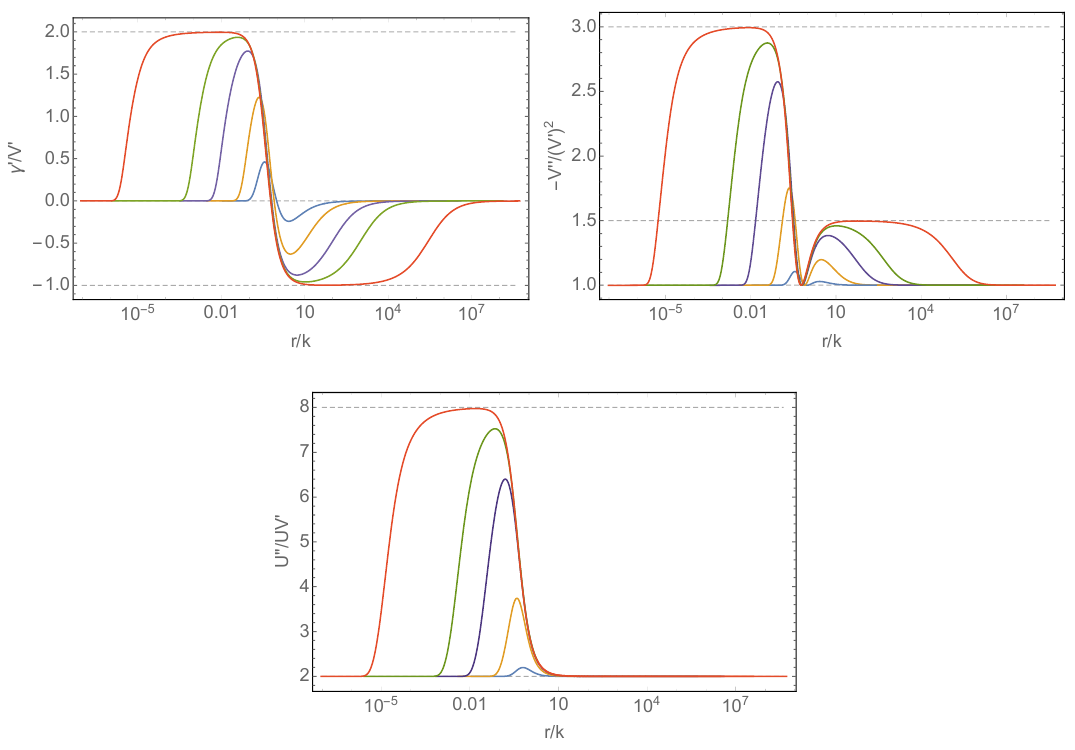
Figure 2 . Plots of various functions associated with the RG (cid:13)ows, as functions of the dimensionless radial coordinate r=k , for various values of the dimensionless deformation parameter (cid:0) =k : blue ((cid:0) =k = 1), orange ((cid:0) =k = 10), purple ((cid:0) =k = 10 2 ), green ((cid:0) =k = 10 3 ) and red ((cid:0) =k = 2 : 6 (cid:2) 10 5 ). The plots demonstrate the boomerang RG (cid:13)ow from AdS 4 in the UV to AdS 4 in the IR for all values of (cid:0) =k . For su(cid:14)ciently large values of (cid:0) =k , on the way to the IR the (cid:13)ows approach two intermediate scaling regimes.